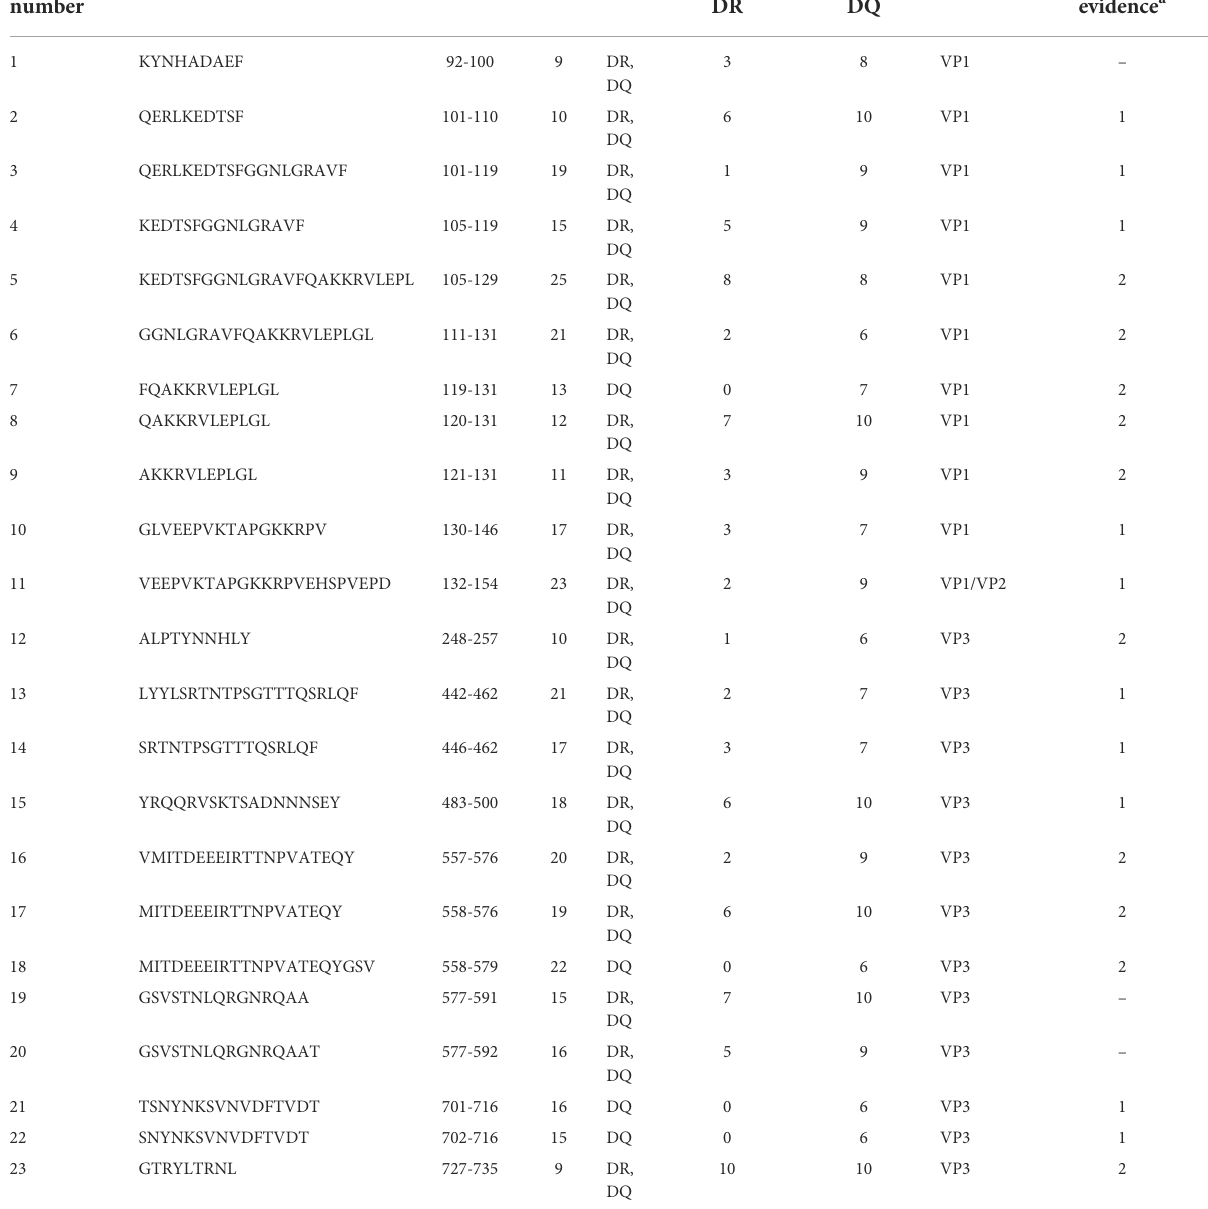
TABLE 2 Promiscuous peptides of AAV2